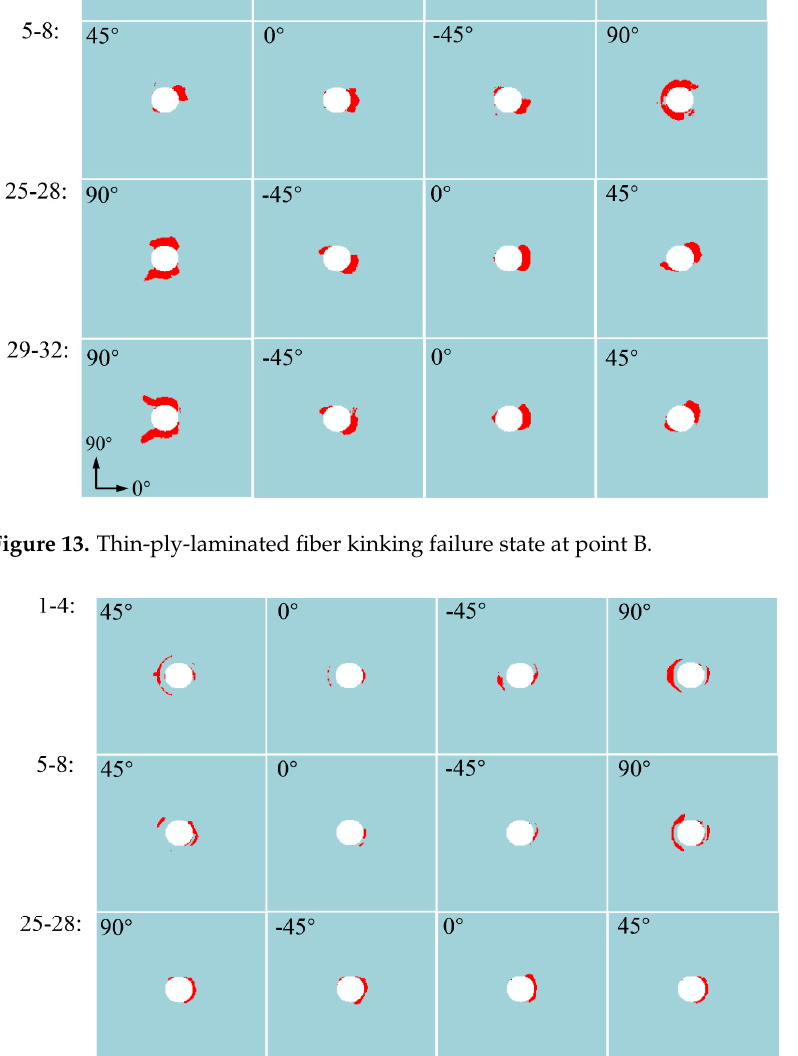
Figure 15. Cohesive element damage state of thin − ply − laminated at point B. As shown in Figure 13, when the structure reaches the peak load ‐ bearing capacity, the kinking failure commonly occurs in the fibers around the laminate hole, and it expands outward at a slow pace along the direction of the fiber. In the upper surface layer, the damage caused by fiber kinking occurs on a small scale in the 90° layer and the area of contact between the outermost layer and the nut. In the lower surface layer, this damage occurs on a small scale as well in all layers except the 90° layer. This also explains why the delamination damage occurring between the 90° fiber layers in the thin ‐ ply laminate com ‐ posite is limited, which is different from the extensive delamination damage caused in the extrusion process of conventional laminate. According to the state of matrix damage, as shown in Figure 14, the matrix damage occurring on the upper surface of the laminate